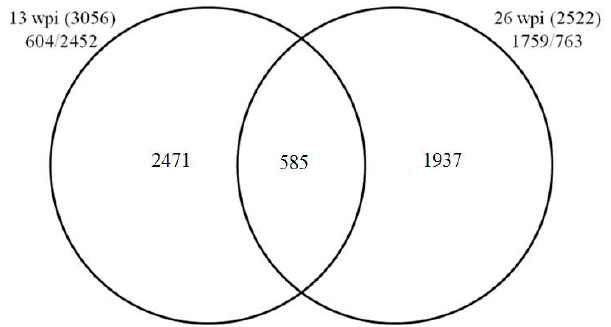
Figure 1. Differential regulation of genes in leaves at 13 and 26 weeks post inoculation (wpi). Figures in the two parentheses indicate total numbers of differentially expressed genes (DEGs) identified in leaves 13 and 26 wpi, respectively. Figures before virgules indicate numbers of upregulated DEGs, and those after virgules indicate the downregulated.